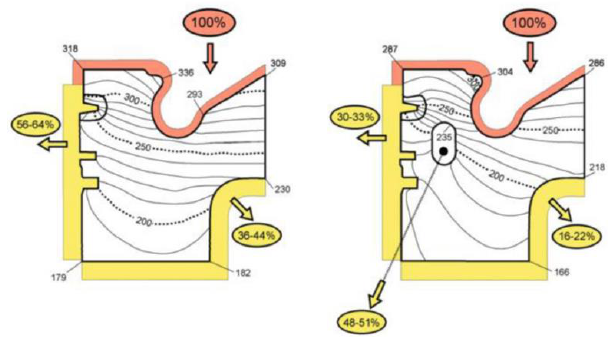
Fig. 2. Temperature distribution of the combustion chamber of a diesel engine piston with and without a cooling channel [11]